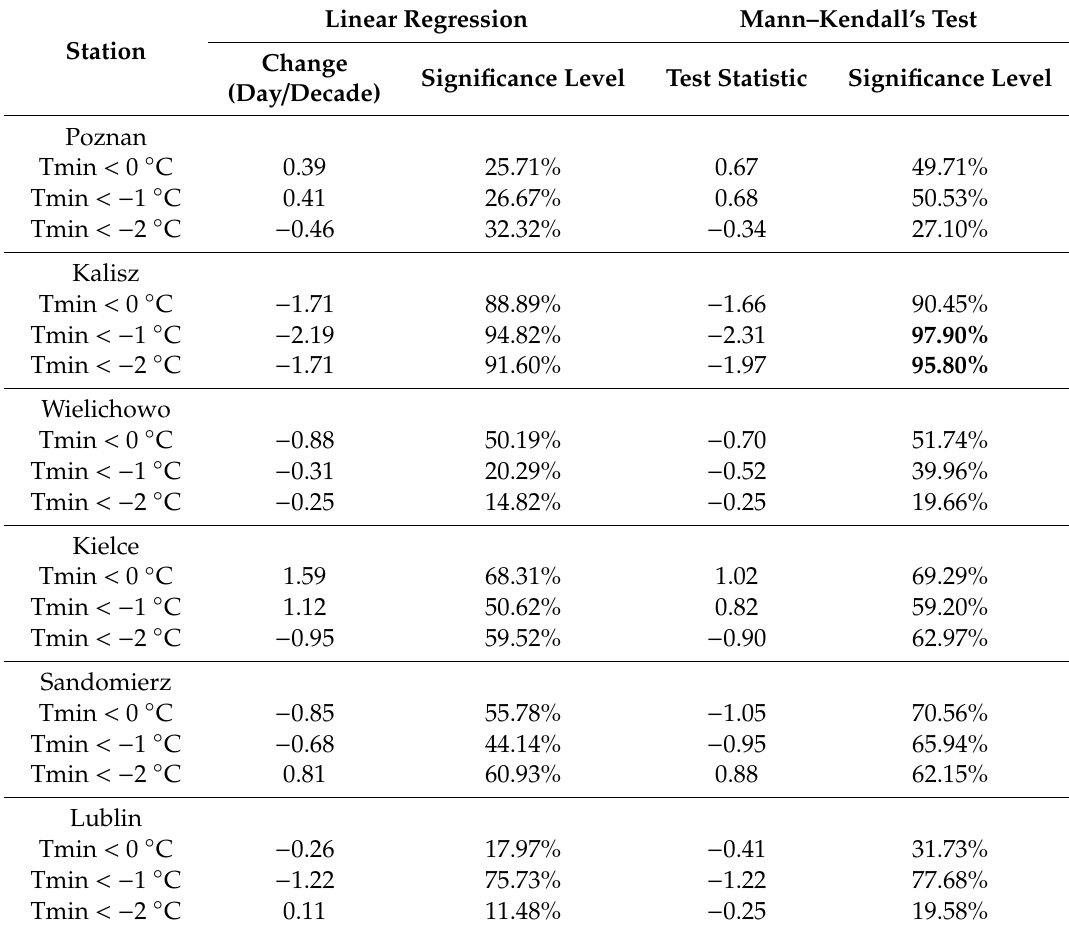
Table 2. Trend characteristics of the last spring air frosts date in relation to the growing season